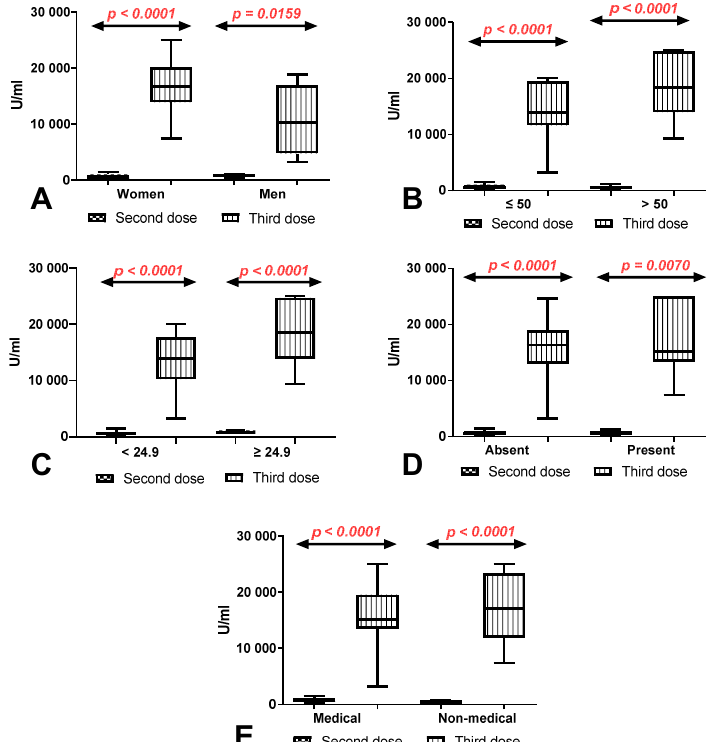
Figure 4. ( A ) Comparison of difference in total anti-SARS-CoV-2 antibody levels between first (after 8 months) and second determination (after 10 months) in the groups of women and men with and without a history of COVID-19. The data are presented as median (minimum–maximum). ( B ) Com- parison of difference in total anti-SARS-CoV-2 antibody levels between first (after 8 months) and second determination (after 10 months) in the groups of patients under and over the age of 50 with and without a history of COVID-19. The data are presented as median (minimum–maximum). ( C ) Comparison of difference in total anti-SARS-CoV-2 antibody levels between first (after 8 months) and second determination (after 10 months) in the group of patients with normal and increased BMI with and without a history of COVID-19. The data are presented as median (minimum–maximum). ( D ) Comparison of difference in total anti-SARS-CoV-2 antibody levels between first (after 8 months) and second determination (after 10 months) in the groups of patients with and without coexisting diseases with and without a history of COVID-19. The data are presented as median (minimum–maximum). ( E ) Comparison of difference in total anti-SARS-CoV-2 antibody levels be- tween first (after 8 months) and second determination (after 10 months) in the groups of medical